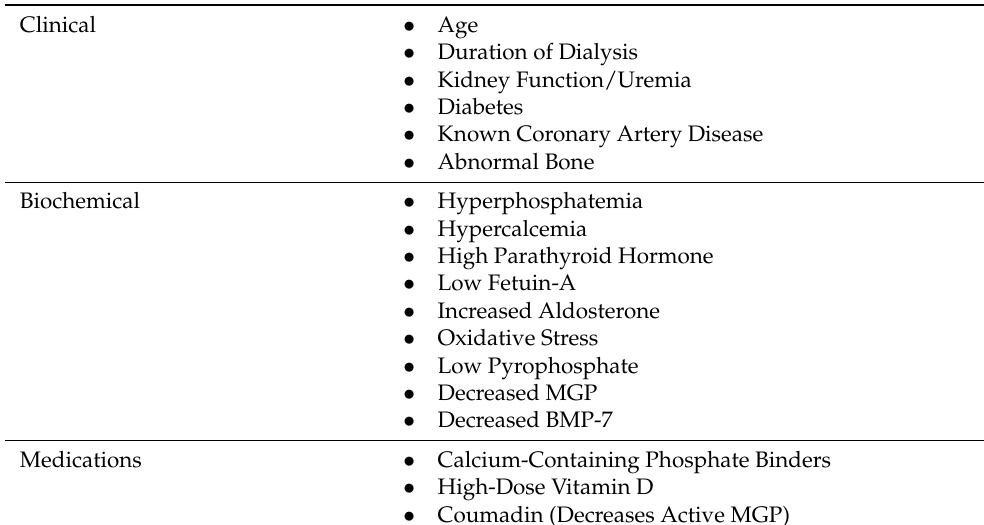
Table 1. Risk factors for vascular